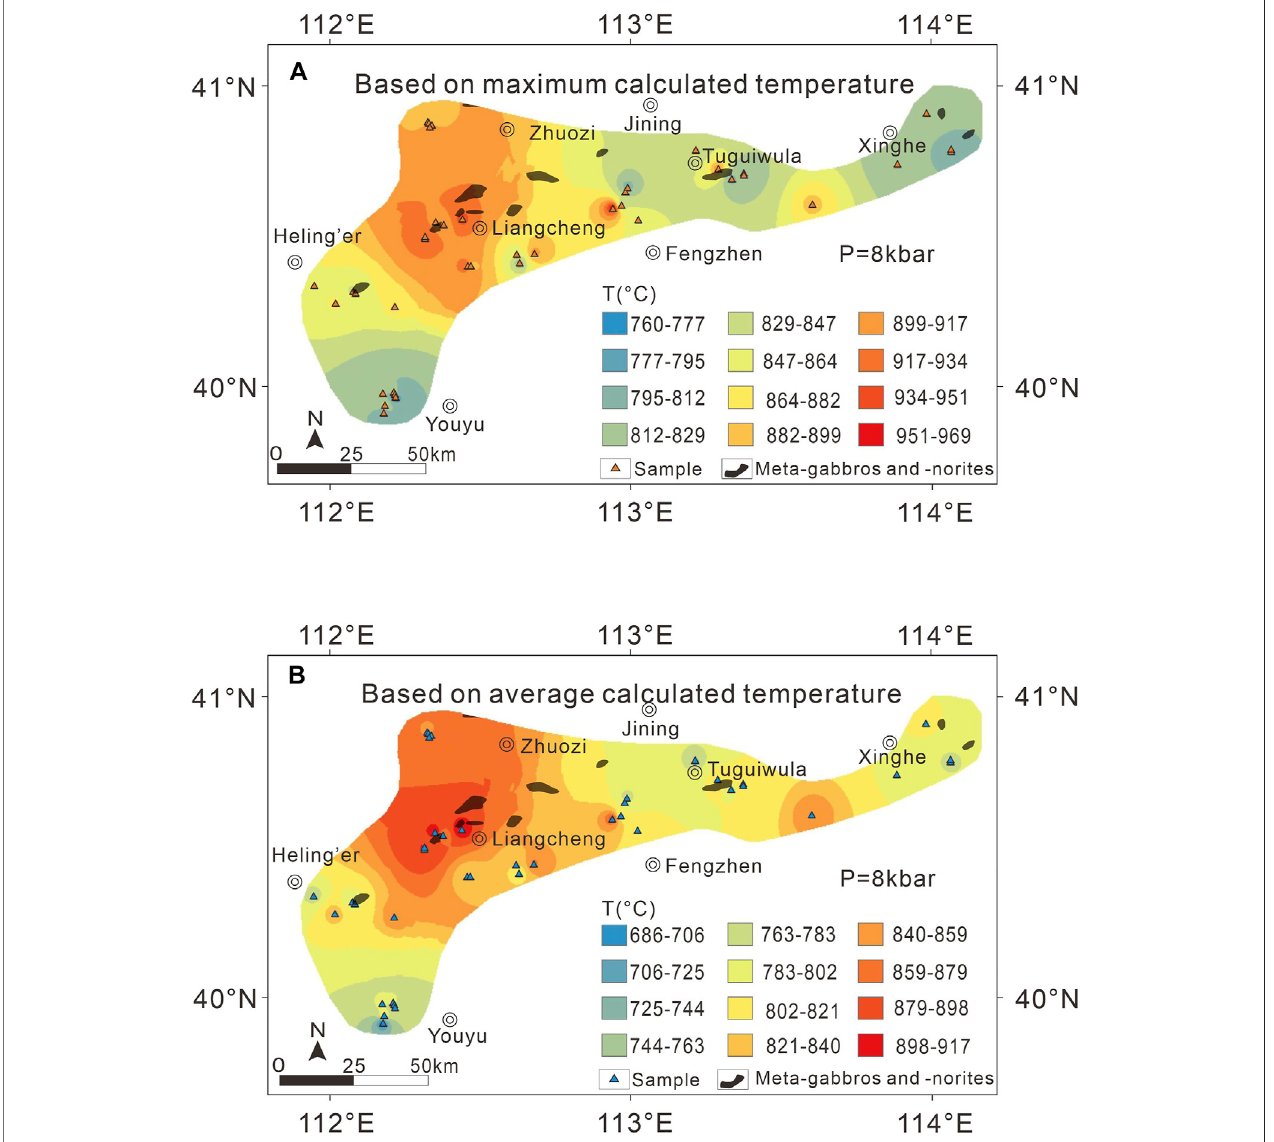
FIGURE 10 | The thermal regime of the lower crust of the eastern Khondalite Belt, North China Craton, constrained by TitaniQ thermometer in this study. (A) Metamorphic temperature mapping with the maximum calculated temperatures of matrix-type quartz. (B) Metamorphic temperature mapping with the average calculated temperatures of matrix-type quartz. The mapping was conducted by ArcGIS, with inverse distance weighted (IDW) method. Sample localities are marked as triangle labels.